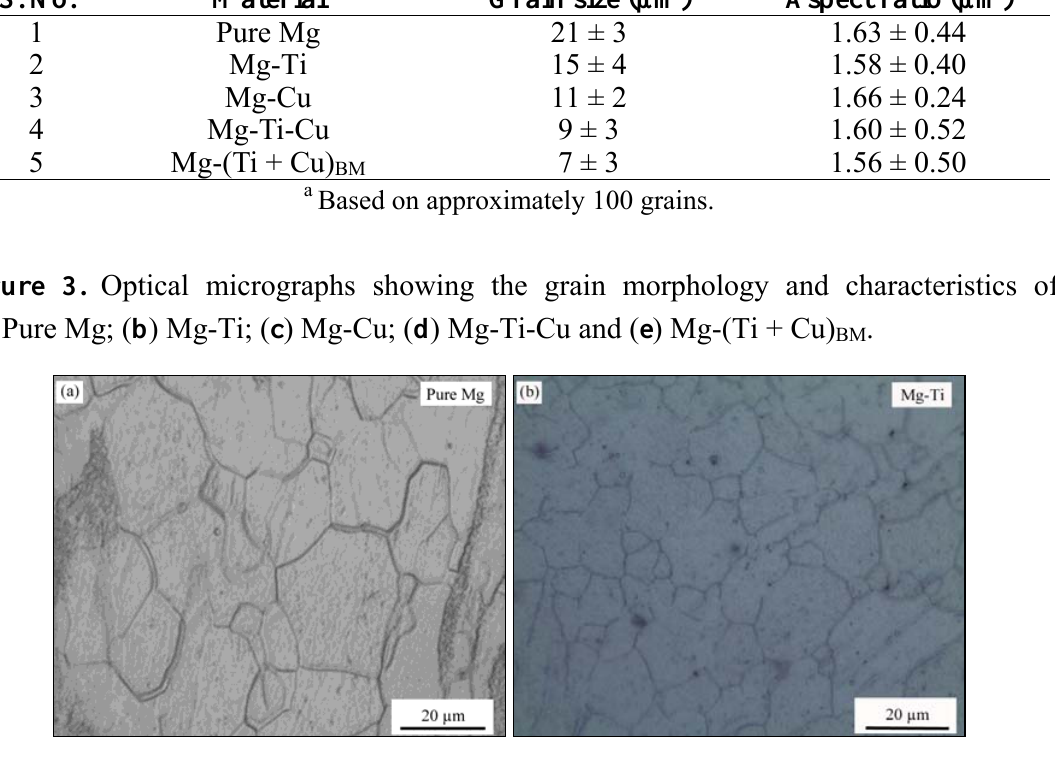
Table 2. Results of microstructure studies a .